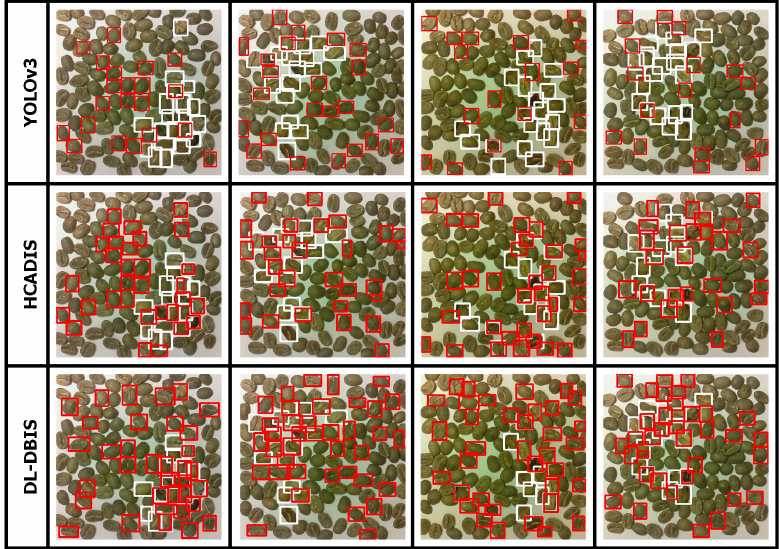
Figure 14. Visualized effects of different algorithms. Four bean images are used to illustrate the results of YOLOv3 [24,37], HCADIS [36], and our proposed